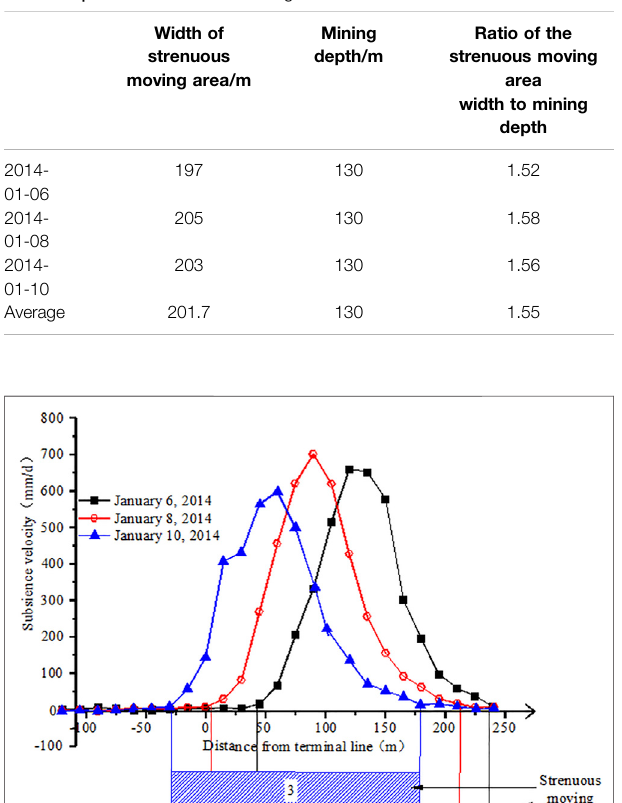
TABLE 3 | Width of strenuous moving area.